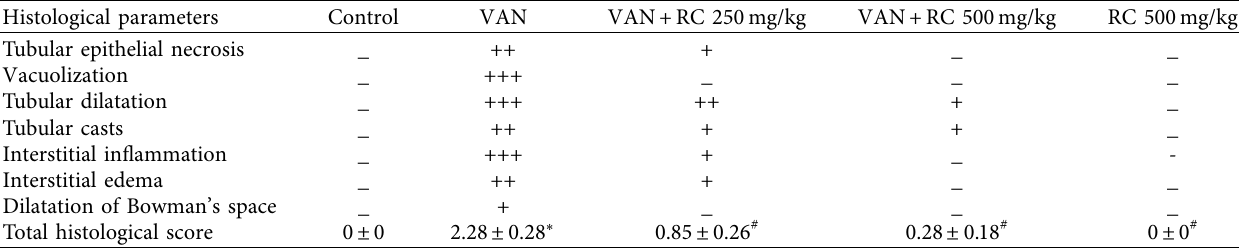
Table 3: Histopathological alteration scoring of renal tissue in experimental groups.